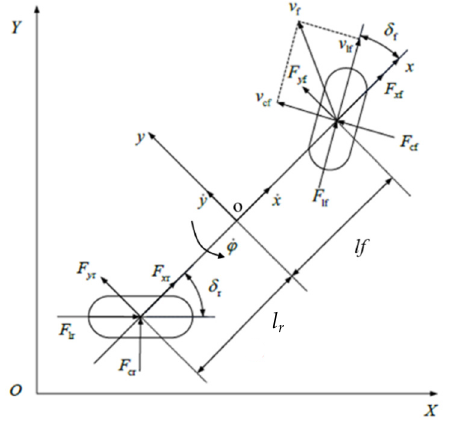
Figure 4. Three-degree-of-freedom vehicle dynamics model.